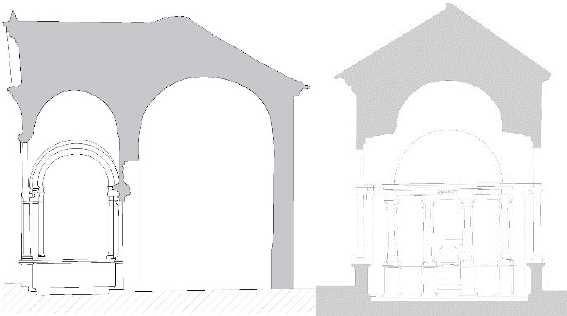
Figure 7: Axial vertical section of the main façade of Chapel two (architectural scale).